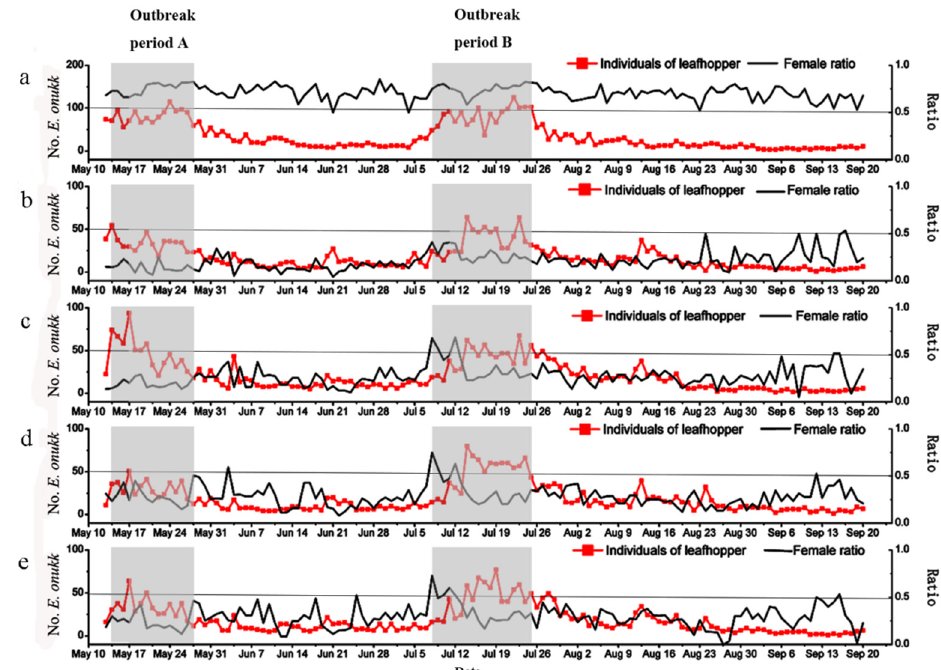
Figure 5. Population dynamics and female ratios of Empoasca onukii trapped/collected in the five treatments during the course of field experiment (13 May to 20 September 2015). ( a ) suction machine; ( b ) yellow sticky card; ( c ) white light trap; ( d ) green light trap; ( e ) yellow light trap. The outbreak period A and outbreak period B were covered with gray shades.